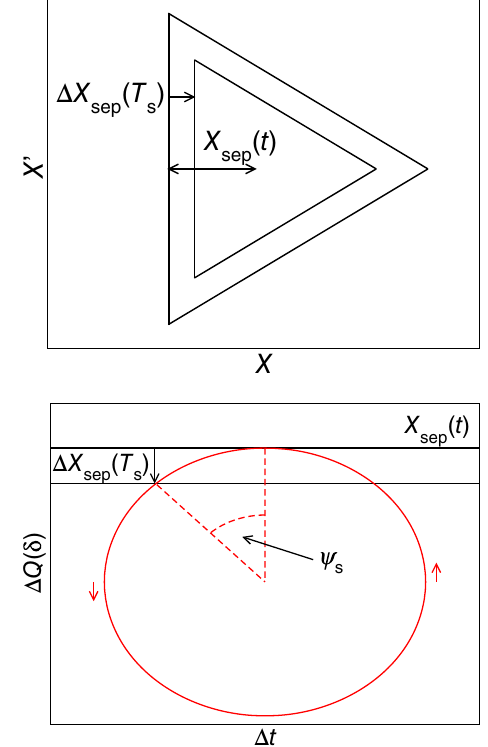
FIG. 2. Upper graph: Schematic plot of the stable phase space area at instant t and shrunk within a synchrotron period T moving the machine tune Q x; Lower graph: Range of longitudinal coordinates of particles with certain horizontal emittance related to the distance of the separatrix from the beam center X within a synchrotron period T